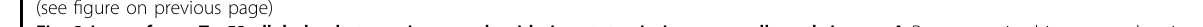
Fig. 2 Loss of one Trp53 allele leads to an increased oxidative status in immune cells and tissues. A Representative histograms showing oxidative stress analysis by fl ow cytometry using CellROX reagent in the major subsets of blood leukocyte samples: lymphocytes, monocytes, and granulocytes from 4-month-old p53 WT, HEM, and KO mice. B Quanti fi cation of CellROX by fl ow cytometry analysis. Five mice per genotype were analyzed. C Myeloperoxidase (MPO) activity analysis in peripheral blood leukocytes, spleen and thymus samples from 4-month-old WT, HEM, and KO mice. At least fi ve mice per genotype were analyzed. Graphs represent the absorbance (ABS) of O-dianisidine dihydrochloride, which re fl ect the amount of H 2 O 2 processed by MPO. D Relative mRNA expression of the Myeloperoxidase ( Mpo ) gene in bone marrow-derived macrophages (BMDMs), spleen and thymus from 4-month-old WT, HEM, and KO mice. For BMDM quanti fi cation, biological replicates were performed in fi ve independent experiments. For hematopoietic tissues quanti fi cation, at least eight mice per genotype were analyzed. E Protein expression of ciclooxygenase 2 (COX2) and inducible nitric oxide synthase (iNOS) in BMDMs of the indicated genotypes treated for 24 h with LPS (100 ng/ml) and/ or IFN γ (1 ng/ml). Relative expression values were referred to β -actin expression. Representative image of a western blot analysis from two independent experiments is shown. In B and D , bars represent mean values ± SEM. AU arbitrary units. Signi fi cant differences and p values were derived from an unpaired t -test, two-tailed. In C , linear regression analyses were performed. WT vs HEM or KO: **** p value < 0.0001, *** p value < 0.0005, ** p value < 0.005, * p value < 0.05, n.s. non-signi fi cant. HEM vs KO: ## p value < 0.005, # p value <